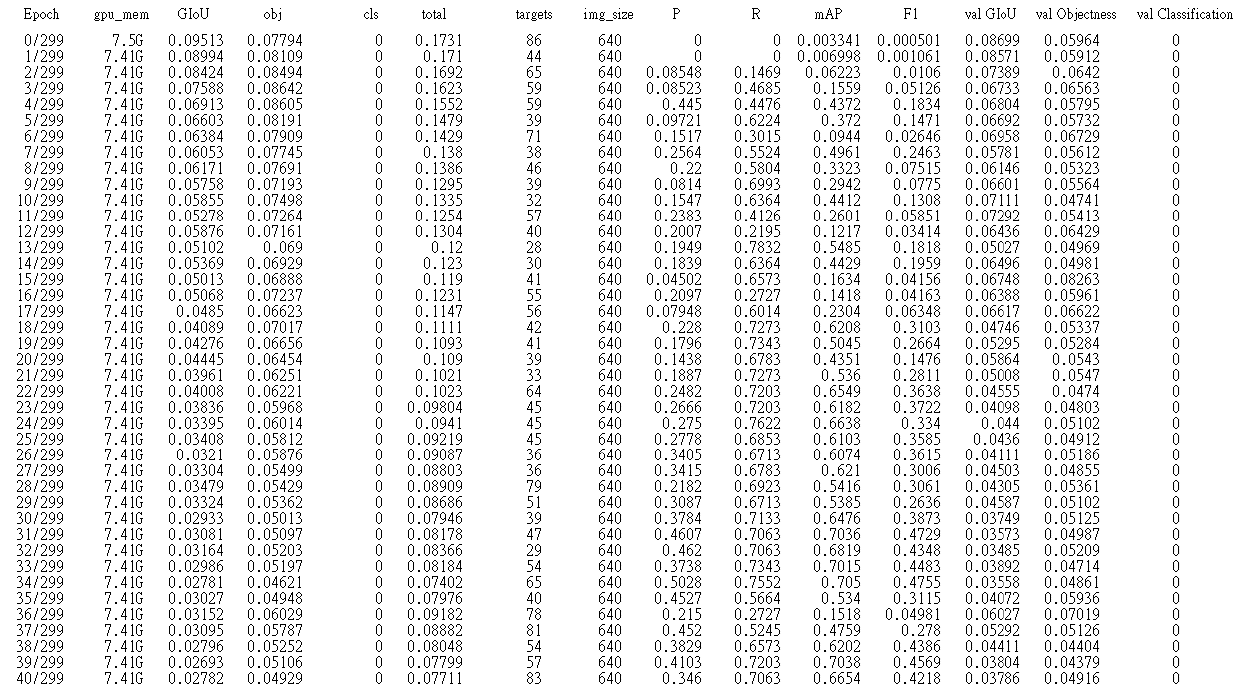
Figure 11. Log from the training phase.